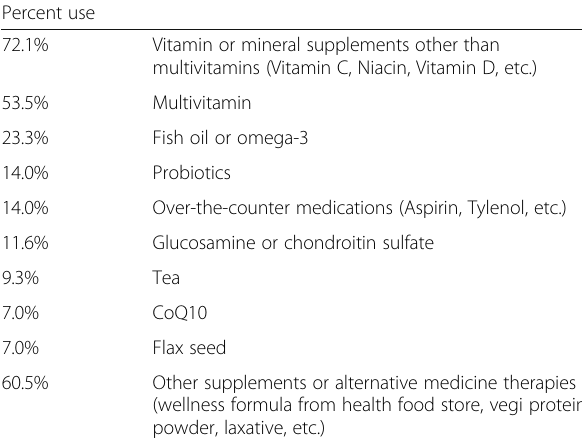
Table 2 Supplement or alternative medicine therapy